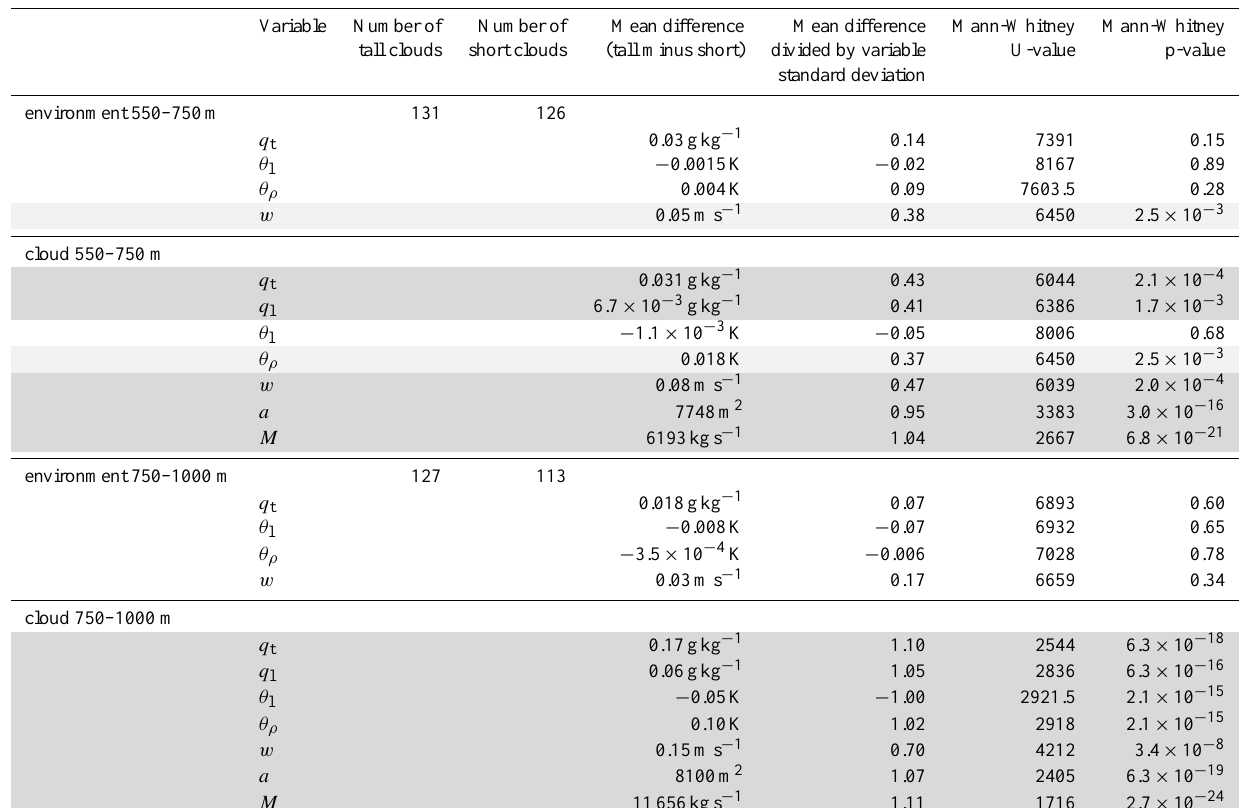
Table 1. Mann-Whitney U-test results comparing differences between encountered environment and rising cloud top properties for tall vs short clouds. For average properties between 550–750m, tall clouds are defined as clouds that reach heights over 1050m; for average properties between 750–1000m, tall clouds are those that reach heights over 1300m. Shown are differences in the means (tall minus short), the differences in the means normalized by the standard deviation, the U-value, and the p-value that this U-value would arise for two samples taken from the same distribution. Variables with p-values < 0.05 (“possibly significant”) are shaded in light grey, and variables with p-values < 2.3 × 10 − 3 (“definitely significant”) are shaded in darker